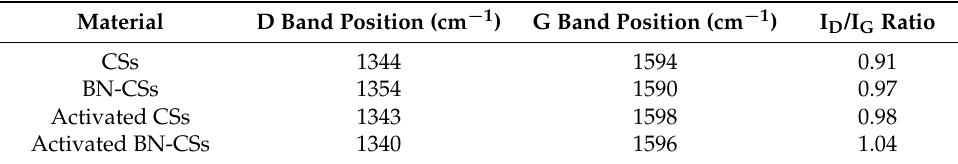
Table 1. The D and G band positions and I D /I G ratio of the CSs and BN-CSs.